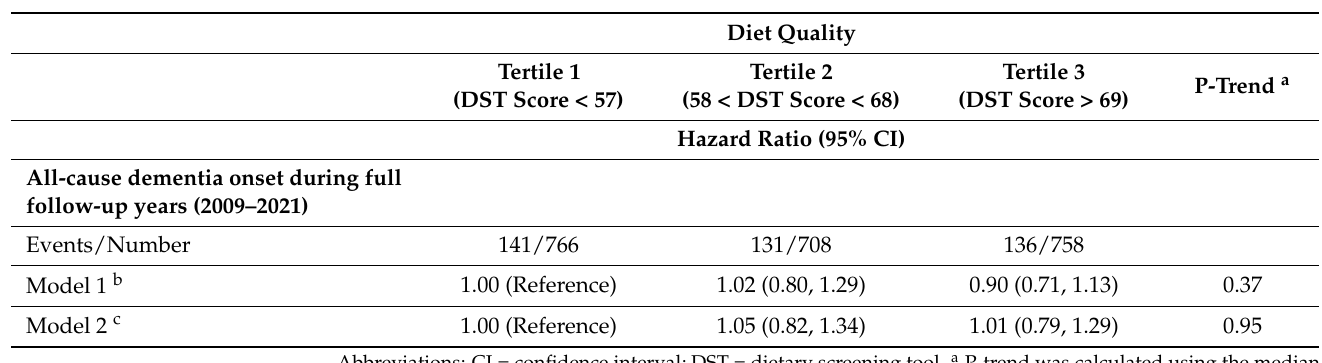
Table 2. Incidence of All-cause Dementia by Diet Quality Tertile Among Geisinger Rural Aging Study (GRAS) Participants.